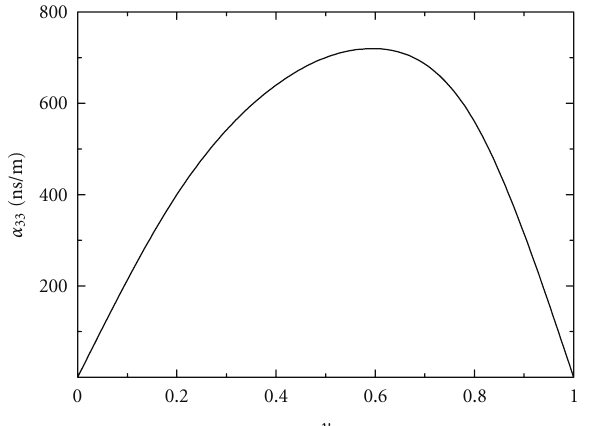
Figure 9: PZT volume fraction dependence of ME voltage coe ffi - cient for CFO-PZT composite with connectivity 3-0 according to model (1) [19] and model (2) [18] for α E ,33 = E 3 / m H 3 and material parameters from Table